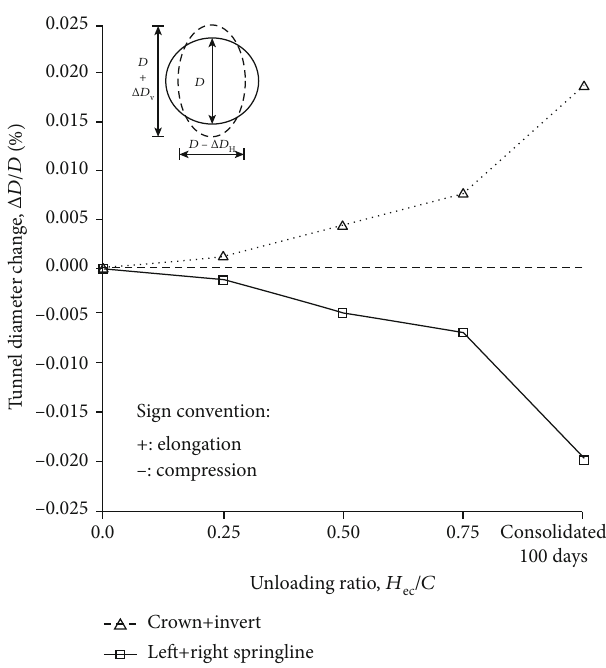
Figure 4: Tunnel diameter change in transverse direction in clay.